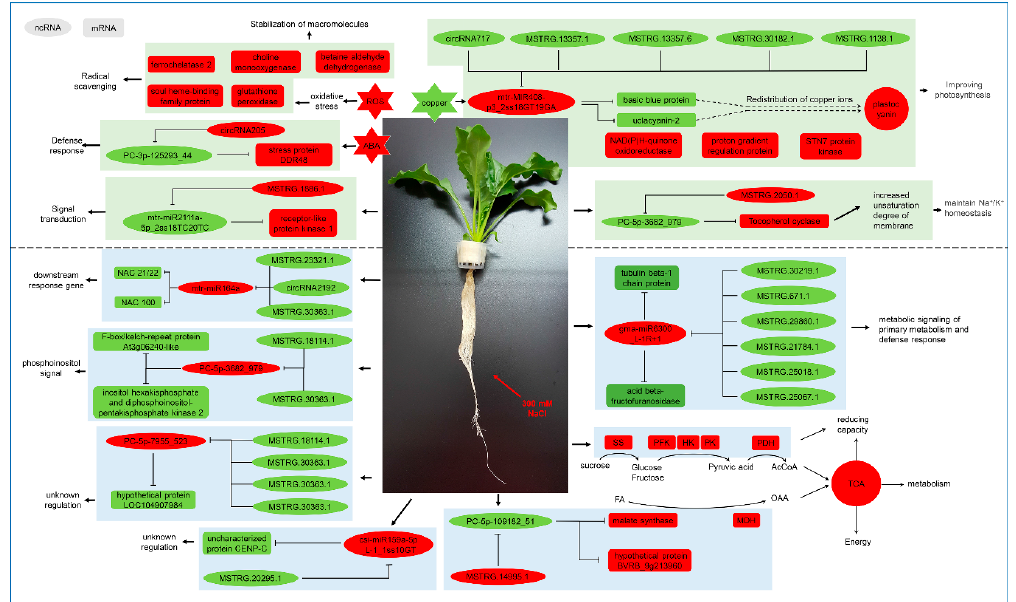
Figure 8. Proposed model of ceRNA network that regulates response to salt stress in sugar beet. SS: sucrose synthase, PFK: fructose phosphate kinase, HK: hexokinase, PK: pyruvate kinase, PDH: pyruvate dehydrogenase, MDH: malic dehydrogenase. Red filling represents up-regulation, whereas green filling represents